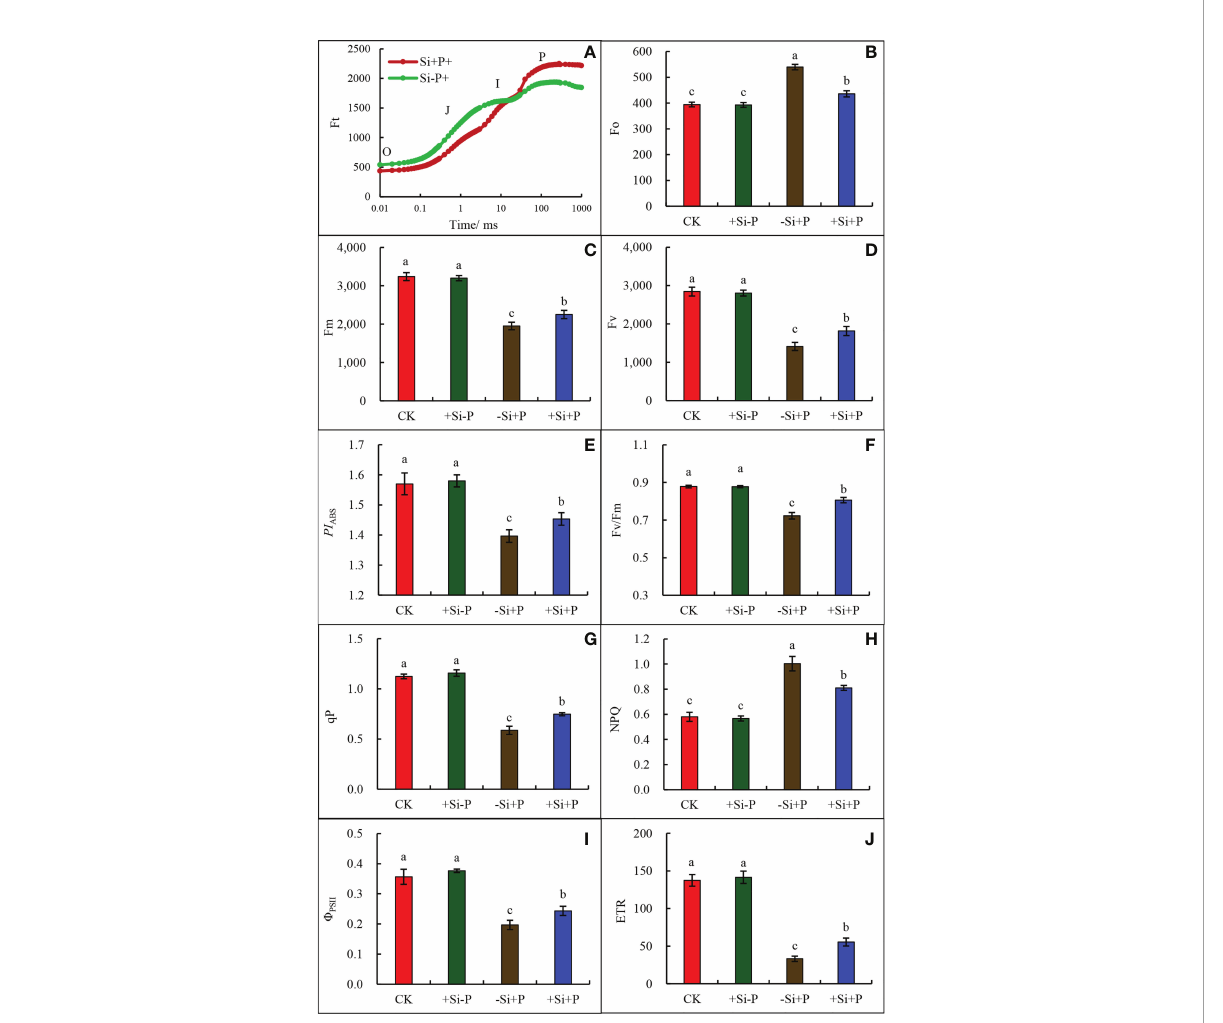
FIGURE 6 Effects of Si application and Pga inoculation on OJIP curves and Chlorophyll fl uorescence parameters of oat leaves. (A) , OJIP curve; (B) , chlorophyll b ( F o ); (C) , maximum fl uorescence ( F m ); (D) , variable fl uorescence ( F v ); (E) , photosynthetic performance index ( PI ABS ); (F) , maximum quantum yield of PSII ( F v / F m ); (G) , Photochemical quenching (qP); (H) , non-photochemical quenching (NPQ); (I) , actual PSII quantum yield ( F PSII); (J) electron transport rate (ETR). CK, no Si application and no Pga inoculation; +Si-P, 1.5 mmol·L – 1 Si application and no Pga inoculation; -Si+P, no Si application and Pga inoculation; +Si+P, 1.5 mmol·L – 1 Si application and Pga inoculation. Data are expressed as mean ± SE (n=3). According to Duncan ’ s multiple comparison tests among treatments, different letters on bars show signi fi cant differences at 0.05 level of